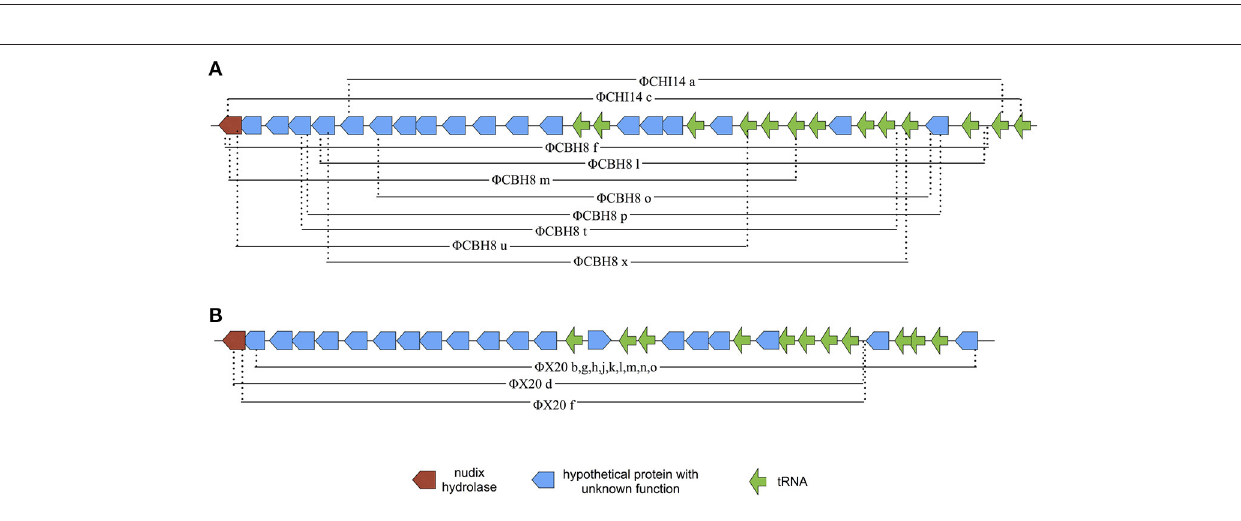
FIGURE 4 | Diagram of the deleted regions in 8 CHI14, 8 CBH8, and 8 X20 mutants. (A) Mapping of “large deletion” regions onto 8 CHI14 and 8 CBH8 genomes shows the start and end of each deletion. The same presentations of the deleted regions are used for 8 CHI14 and 8 CBH8 due to their high similarity. (B) Mapping of “large deletion” regions onto the 8 X20 genome shows the start and end of each